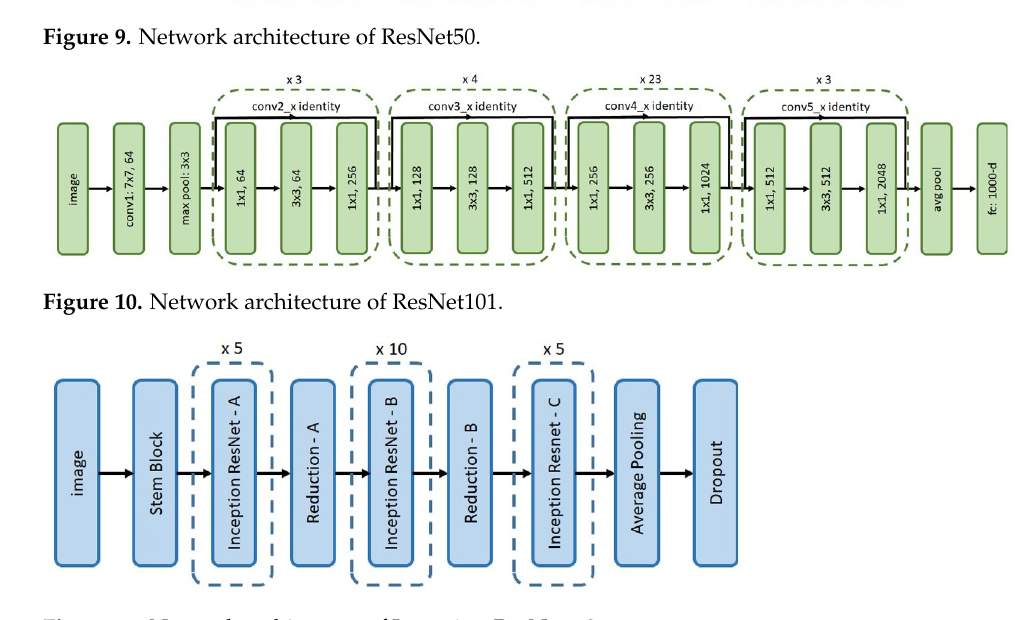
Figure 11. Network architecture of